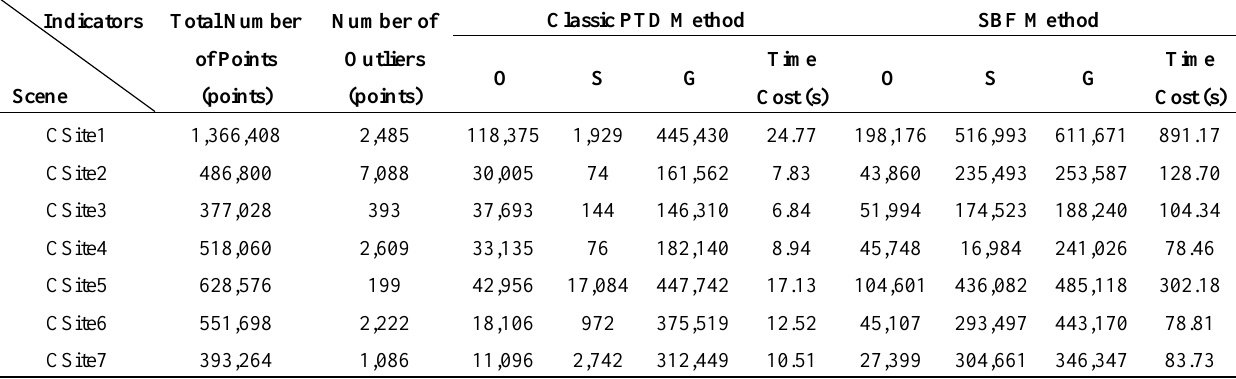
Table 2. Statistics about the filtered results of the two filters for each